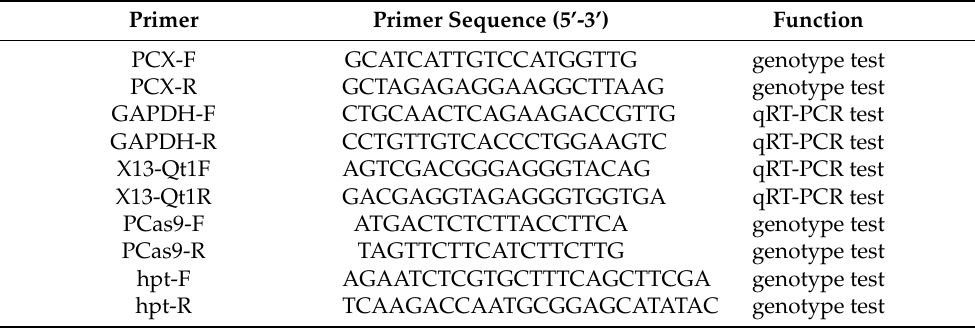
Table 2. List of the primers used for molecular detection of transgenic